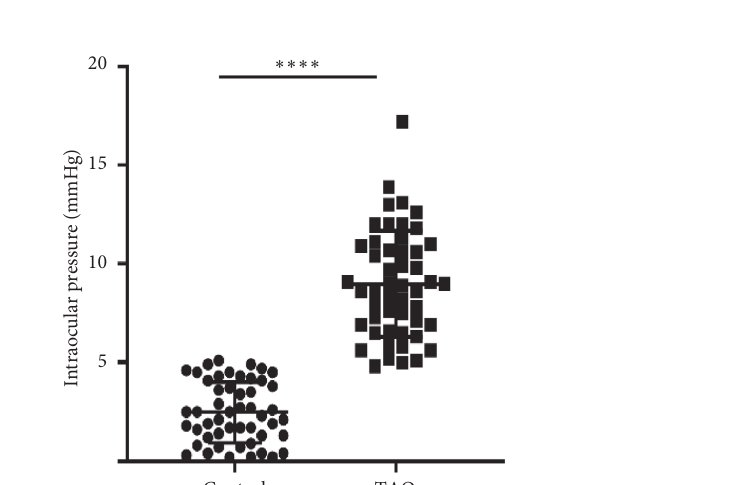
Figure 1: The scatter plot of the distribution of the IOP difference between the upgaze and primary positions in the TAO and control groups.